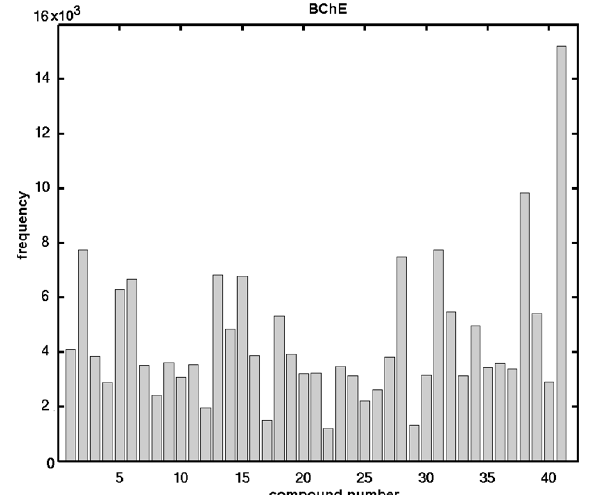
Figure 1. Histogram indicating number of individual compounds that accured in test set within the regions of 𝑞 𝑐𝑣2 > 0.7 and 𝑞 𝑡𝑒𝑠𝑡2 > 0.5 for the training set against 𝑞 𝑡𝑒𝑠𝑡2 L–7–O CV for modeling the BChE potency of the carbamate derivatives ( 1 – 41 ) using CoMSA approach.